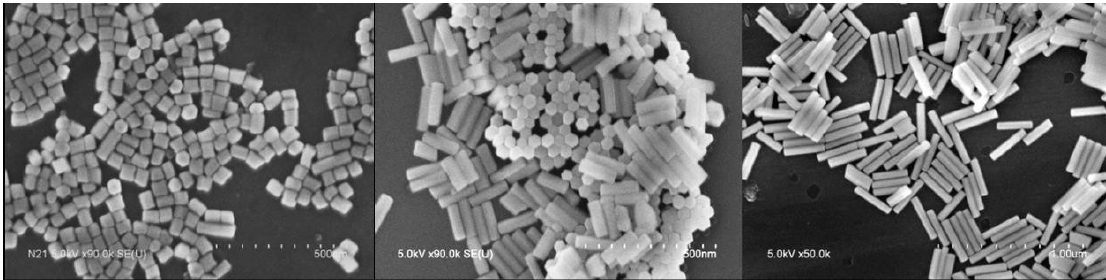
Figure 1. Three SEM images of NaYF 4 NPs (from left to right NR13, NR12 and